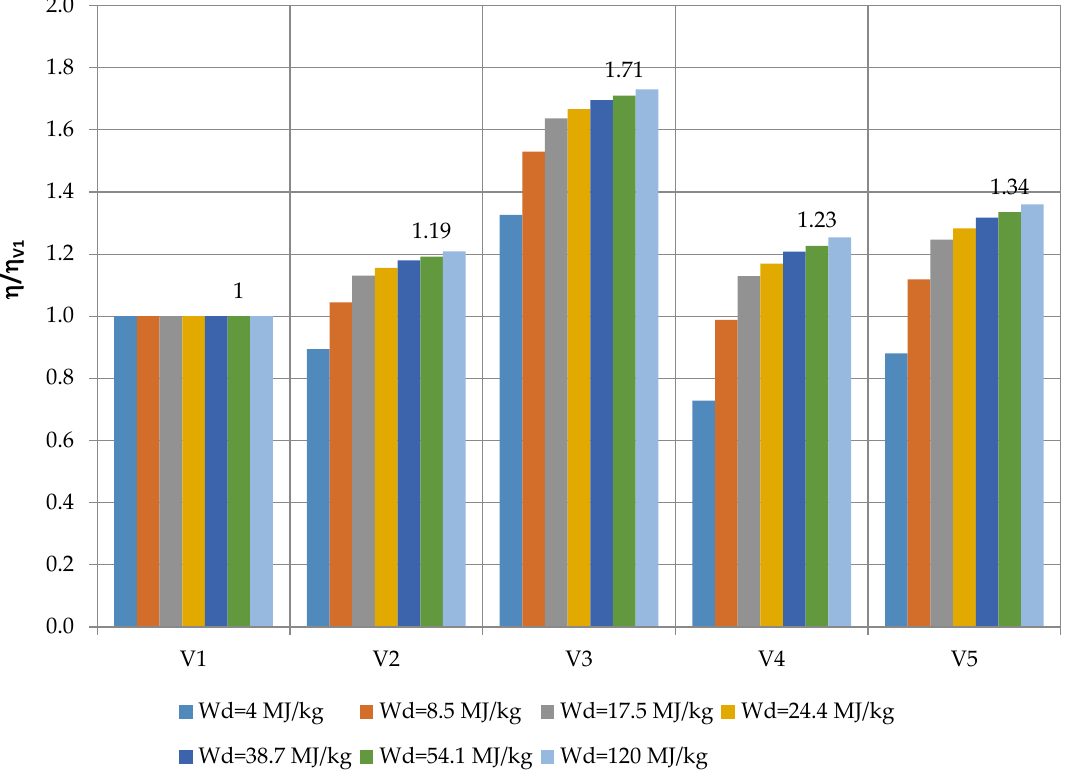
Figure 11. Collective diagram of the influence of the structure of the cycle and calorific value of fuel on the efficiency of the cycle as compared to variant 1.